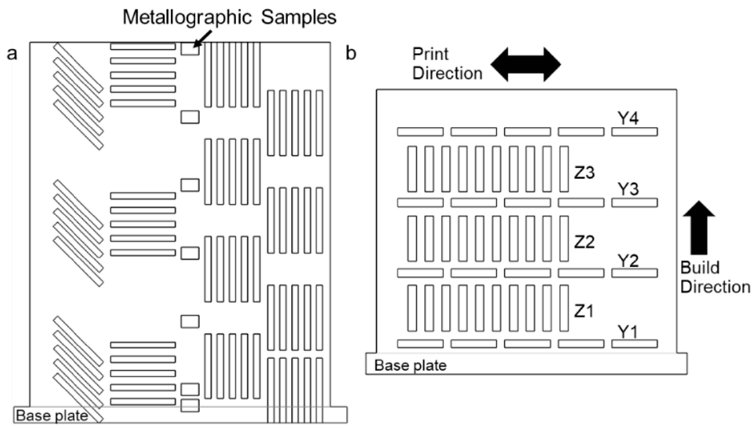
Figure 4. Pictorial representation of the ( a ) metallographic, tensile (572 mm tall by 470 mm long) and ( b ) Charpy v-notch specimens (305 mm tall by 362 mm long).